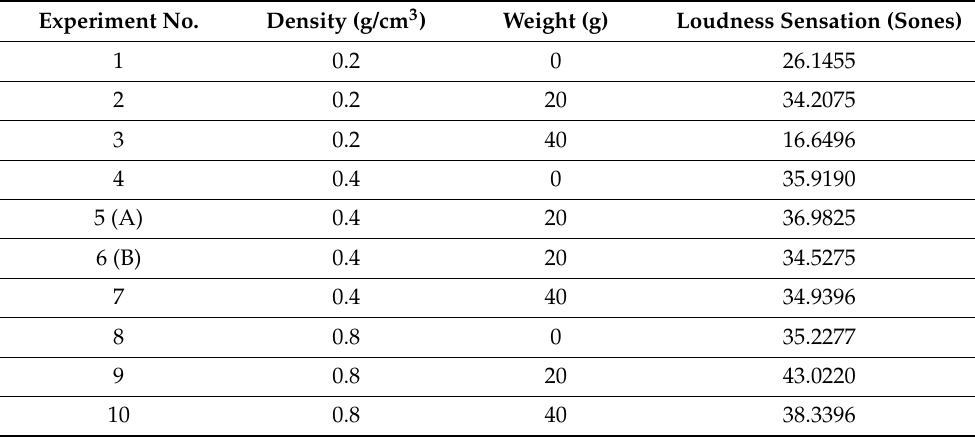
Table 4. The two-way factorial design experiment layout and result. Experiment